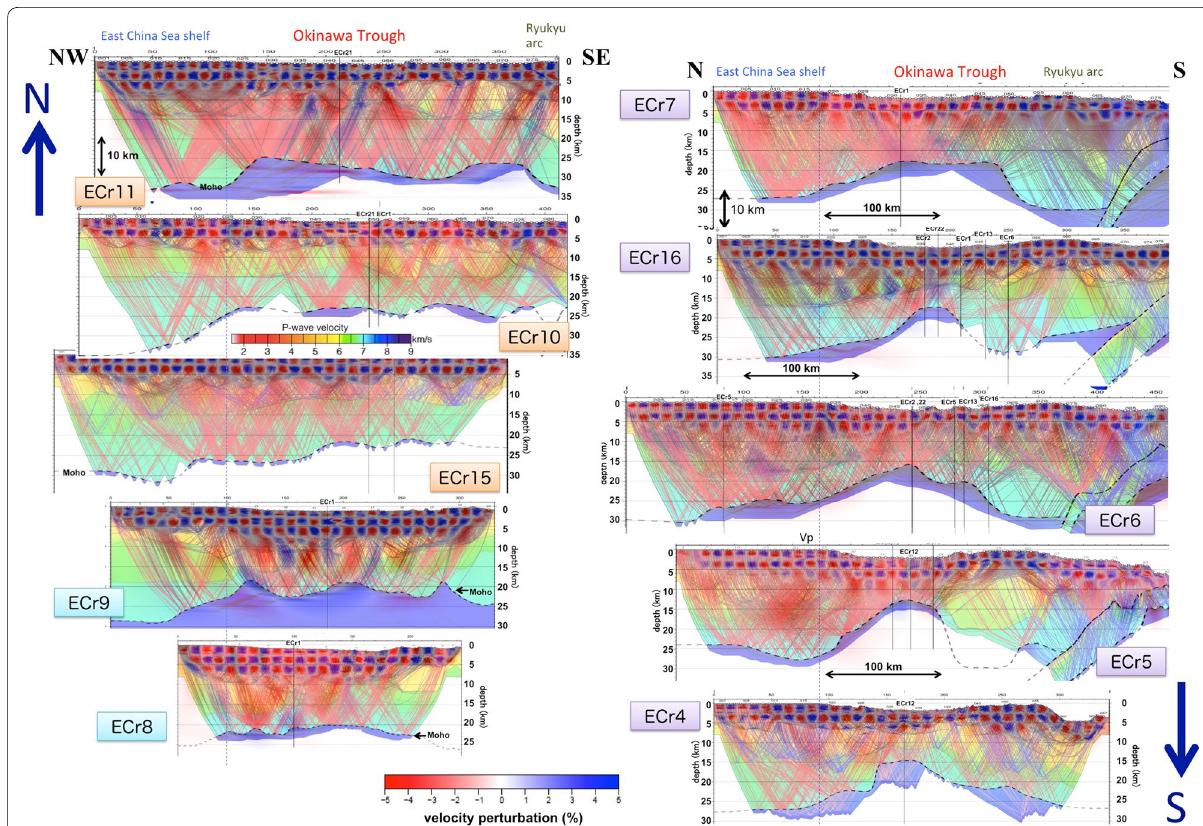
Fig. 6 Results of the checkerboard test for each P wave velocity model shown in Fig. 5. Ray coverage is also plotted from the forward modeling, including reflection waves. The ray paths correspond to manual readings on the observed record sections for each seismic